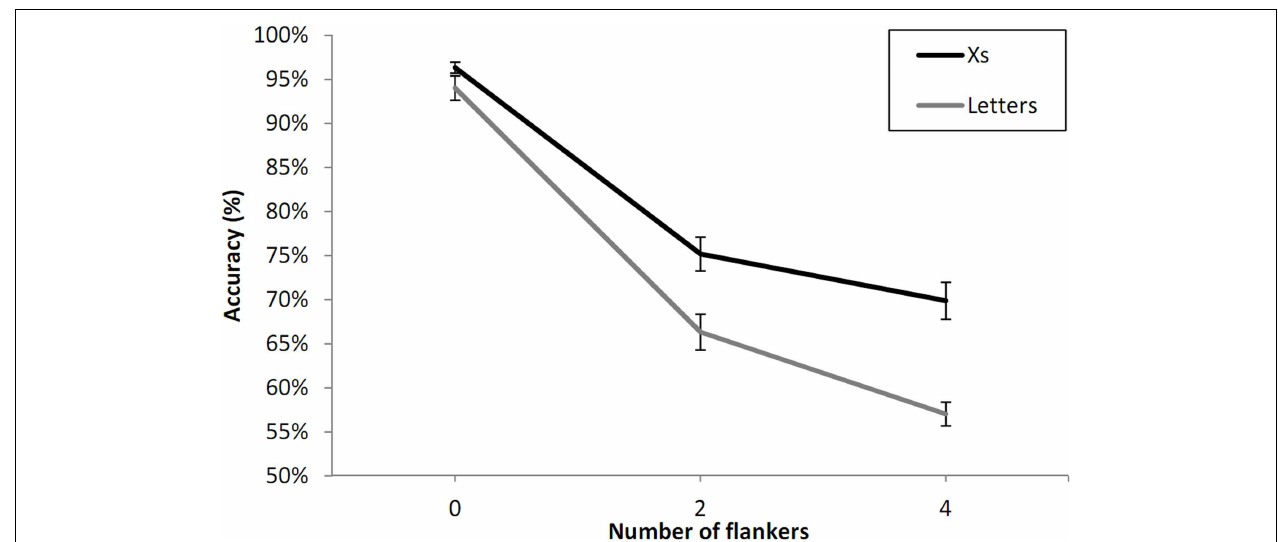
FIGURE 5 | Percent correct 2AFC to letter targets with letter flankers compared with X flankers as a function of the number of flankers in Experiment 1, and averaging across unilateral and bilateral presentation and visual field. Error bars are standard errors.